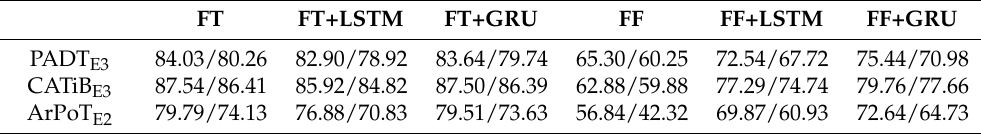
Table 13. UAS/LAS on the test datasets for AraBERTv2 BERT model fully tuned (FT) and fully freezes (FF) with and without additional layers (GRU and